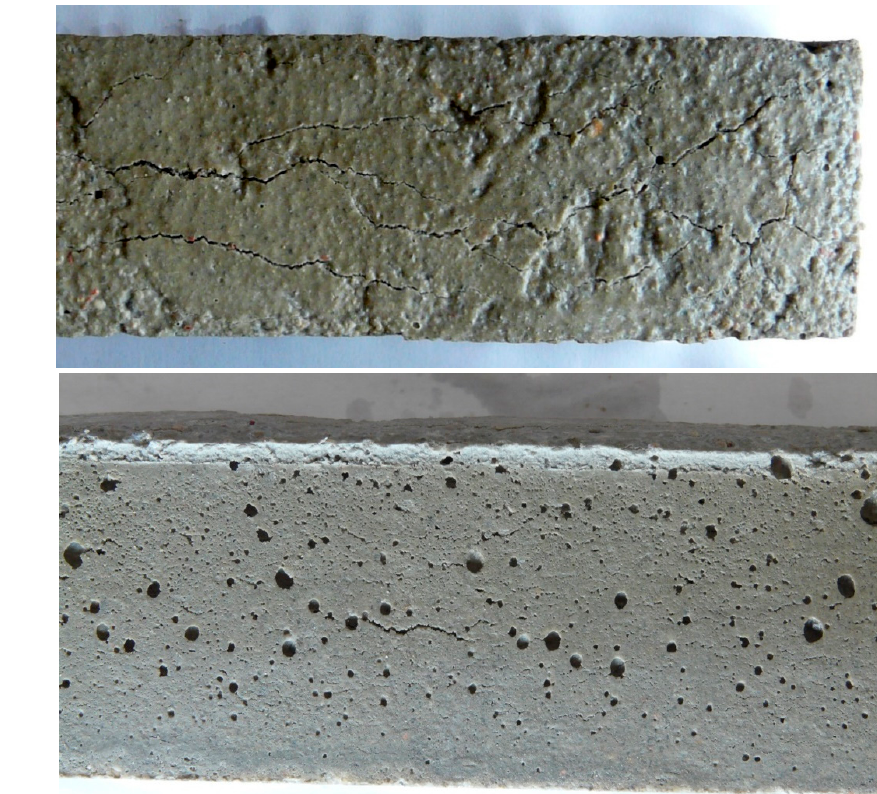
Figure 3. Cracks in the mortar sample with CEM III and gas-liberating admixture content equal to 1.5% of the cement mass ( a ) top surface, ( b ) lateral surface.